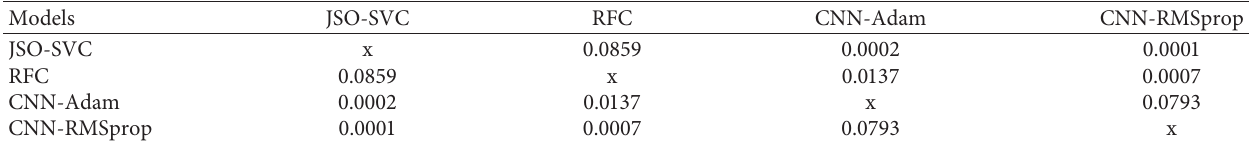
Table 5: p values obtained from Wilcoxon signed-rank test results with AUC